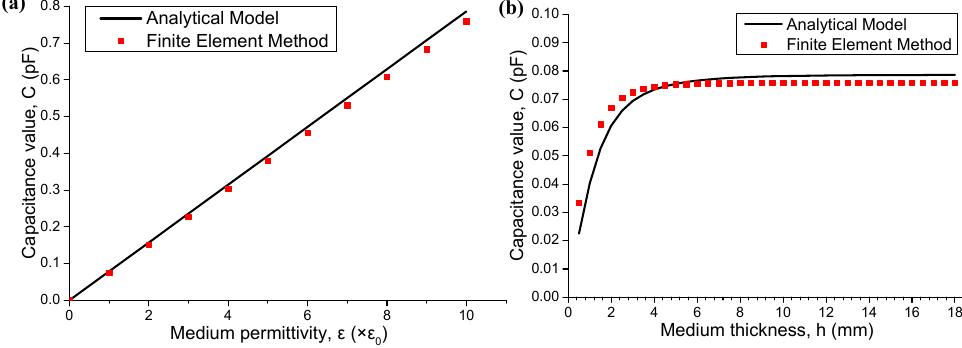
Figure 3. Capacitance values of the capacitors with ( a ) different medium permittivity ε and ( b ) different medium thickness h .